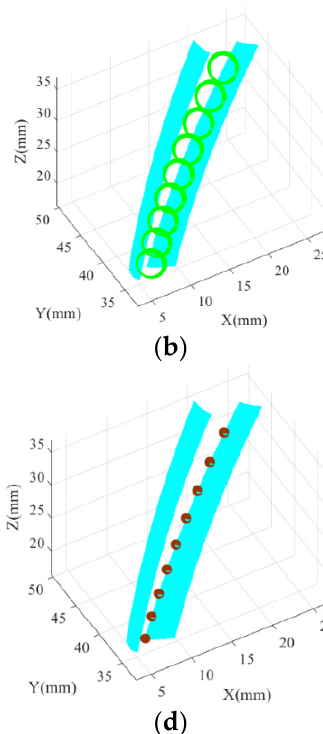
( b ) Figure 13. Machining process of finger milling cutter with double-arc: ( a ) Machining without error compensation; ( b ) Machining with error compensation. Appling the method of error compensation to calculate the machining error, Figure 13b shows the position relationship between the milling cutter and the tooth surface after error compensation. Compared with Figure 13a, there is no overlapping part, which means no machining interference. The tooth surface in Figure 13b is also the actual ma- chined tooth surface. Among them, the error compensation of the convex tooth surface is the smallest, which is 0.005 mm. The error of the concave tooth surface and the transitional tooth surface is 0.030 mm, and the error of the tooth root surface is 0.032 mm.